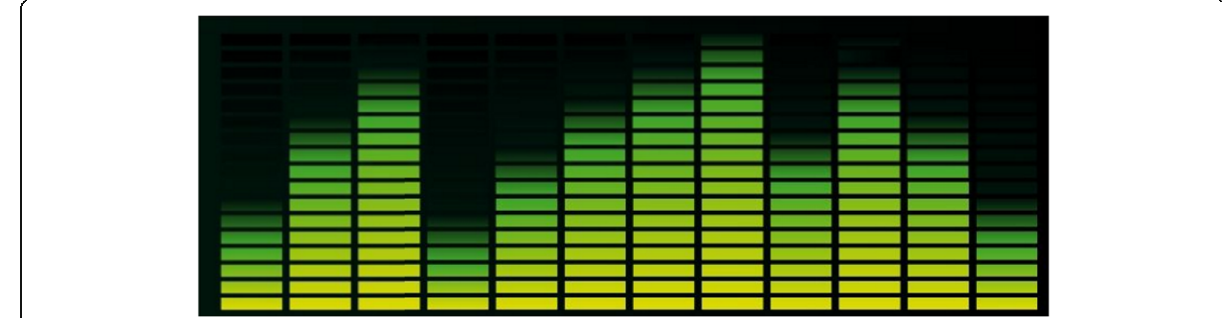
Fig. 7 The g sound image of small group two that Bart uses [o] vowel